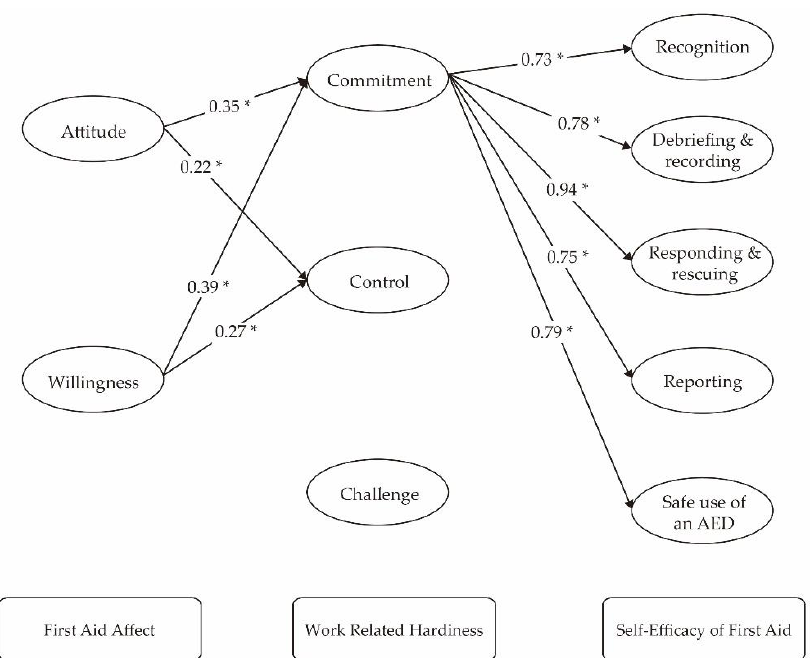
Figure 2. The structural equation model of the relationships among FAA, WRH, and SEFA. * p < 0.001.